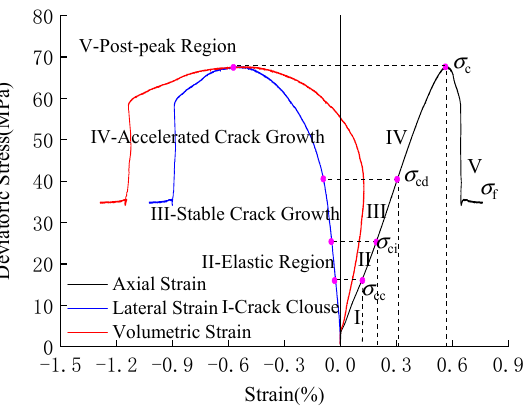
Figure 3. Stage division of stress–strain curve of the fractured sandstone sample under hydro-me- chanical coupling (SF15-2).